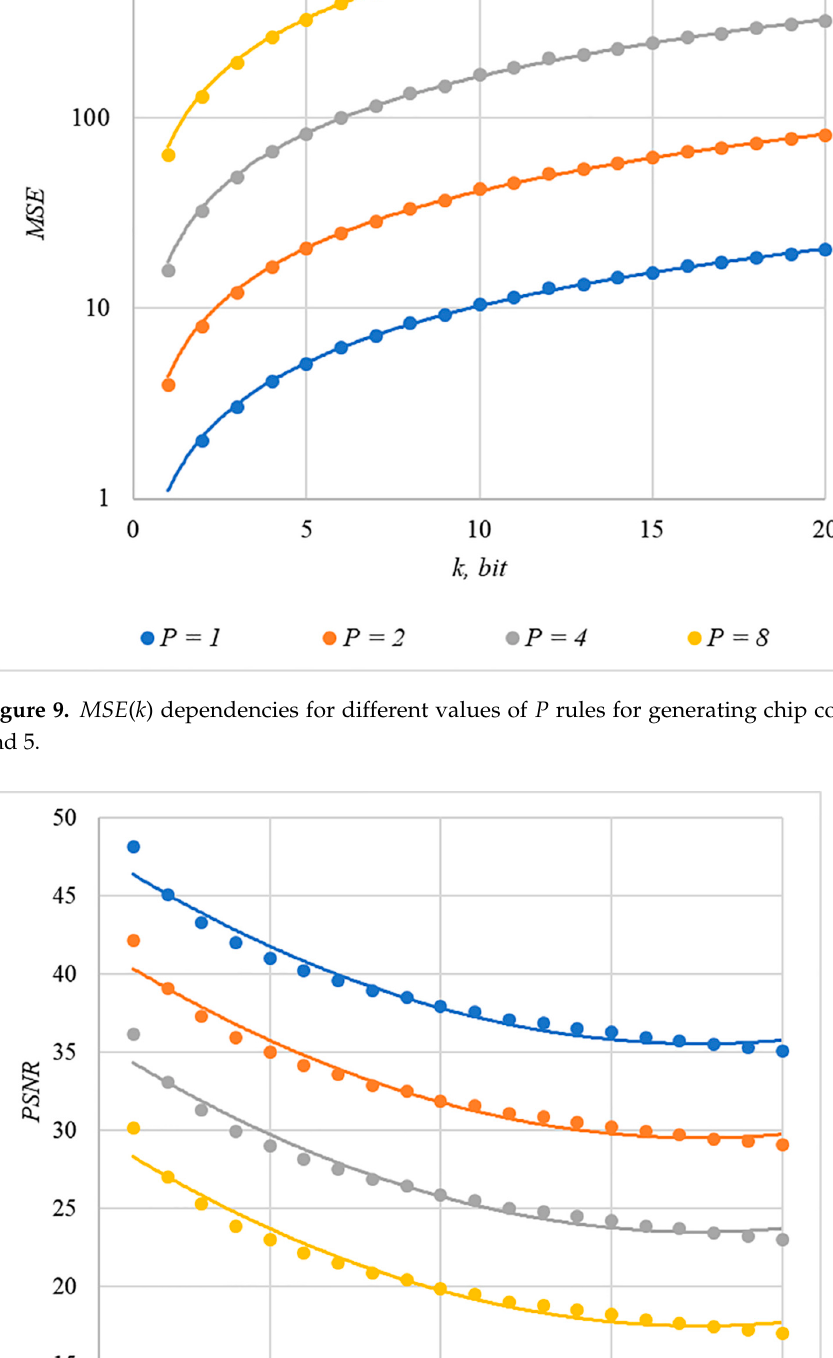
Figure 10. PSNR ( k ) dependencies for different values of P rules for generating chip codes № 1, 3, 4, and